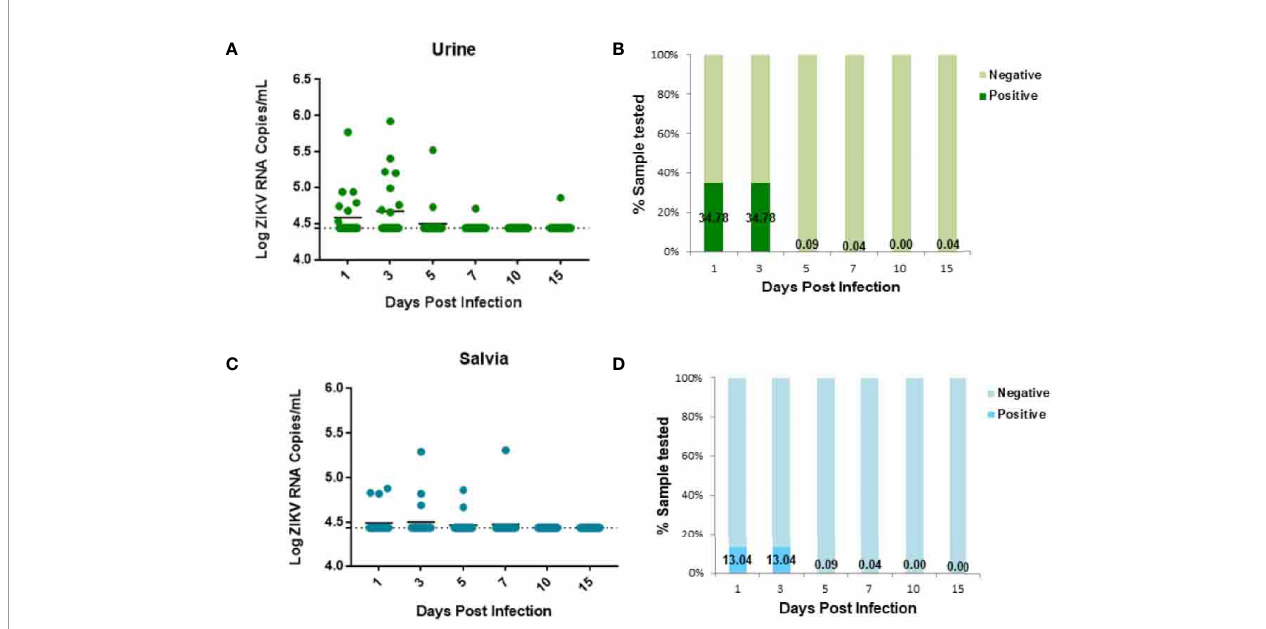
FIGURE 3 | ZIKV establishes systemic infection in tree shrews infected via Vaginal inoculation. Viral loads in urine and saliva were determined by RT-qPCR. (A, B) The kinetics and time courses of viremia in urine of ZIKV-infected tree shrews. (C, D) The kinetics and time courses of the viral load in saliva in infected tree shrews. The detection limit is indicated by the dotted